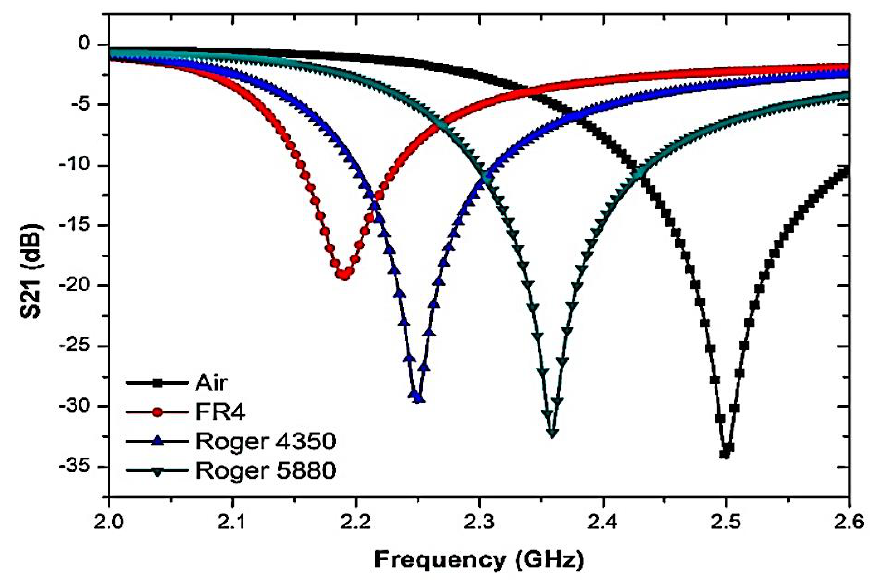
Figure 11. The frequency response of the curve-feed CSRR sensor with the presence of solid SUTs.